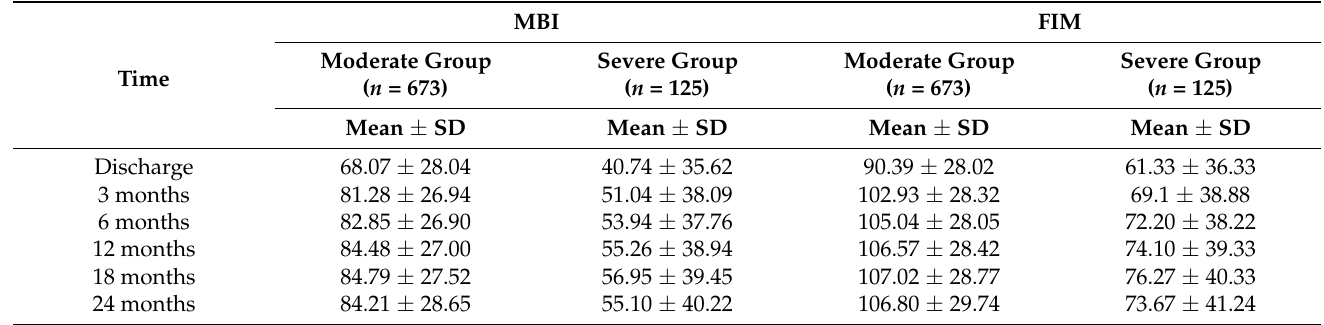
Table 3. Changes in the mean of NIHSS total scores by time period for moderate and severe groups.